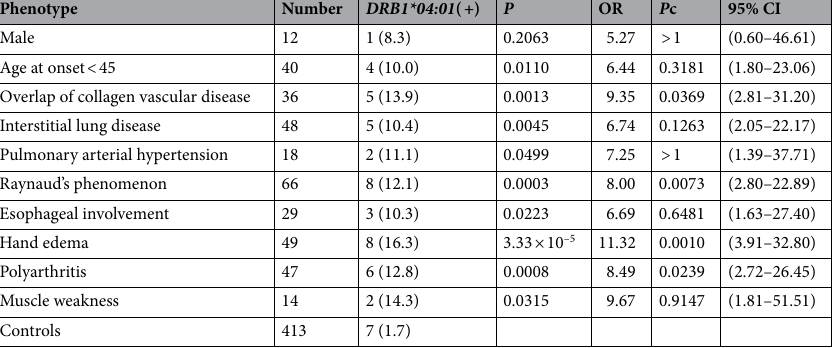
Table 2. Association of HLA-DRB1*04:01 allele carrier frequencies with clinical characteristics of MCTD. DRB1*04:01 allele carrier frequencies are shown in parentheses (%). Association was tested by Fisher’s exact test, using 2 × 2 contingency tables. DRB1*04:01 allele carrier frequency is the frequency of individuals with a DRB1*04:01 allele in each population. Each MCTD subset with clinical characteristics was compared with controls. MCTD: mixed connective tissue disease; OR: odds ratio; CI: confidence interval; P c: corrected P ( Pc values greater than 1 are shown as “ >